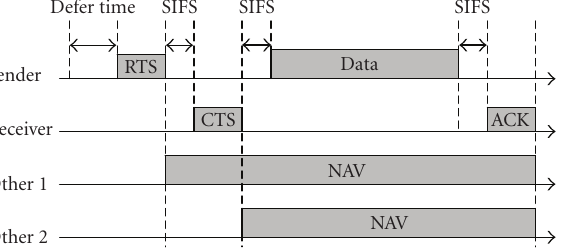
Figure 2: IEEE 802.11 DCF MAC protocol.